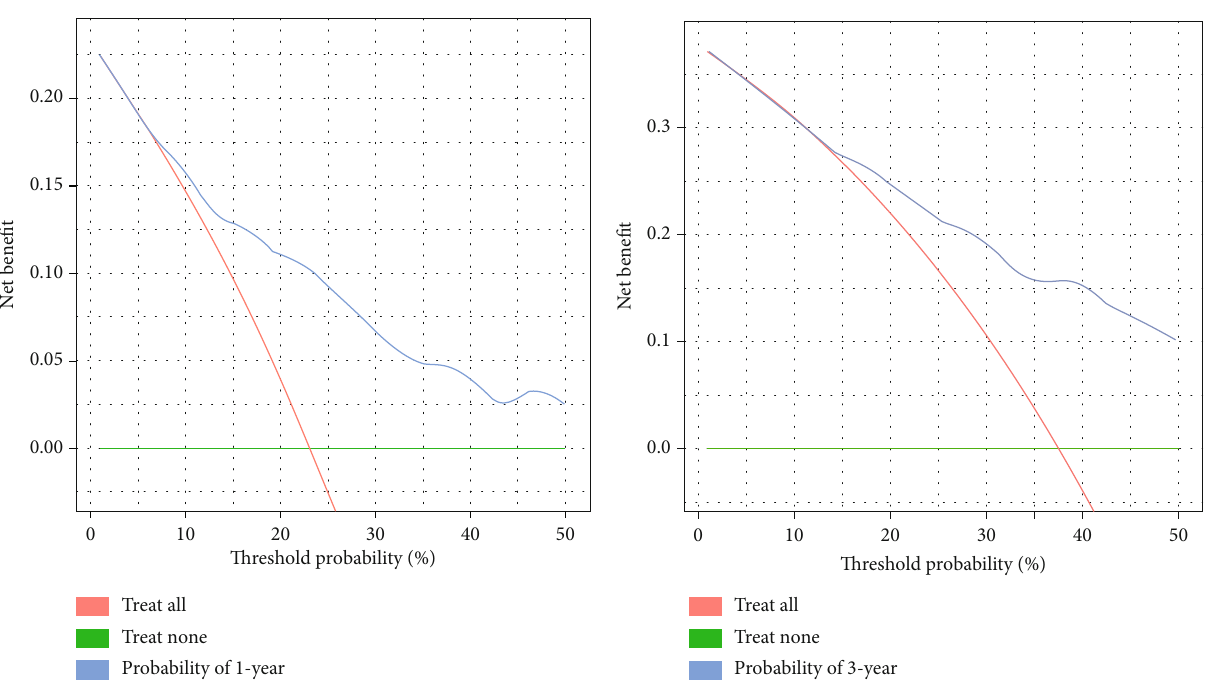
Figure 7: The decision curves in the external validation